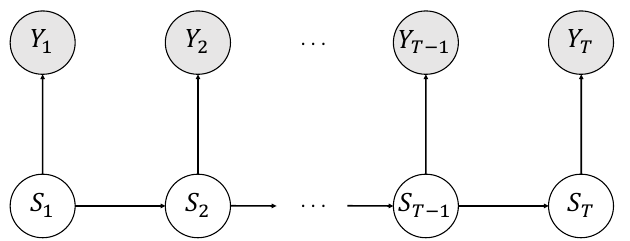
Figure 1. Conditional (in)dependencies structure of a basic LMM. Shaded nodes represent observed variables. White nodes represent unobserved (latent)